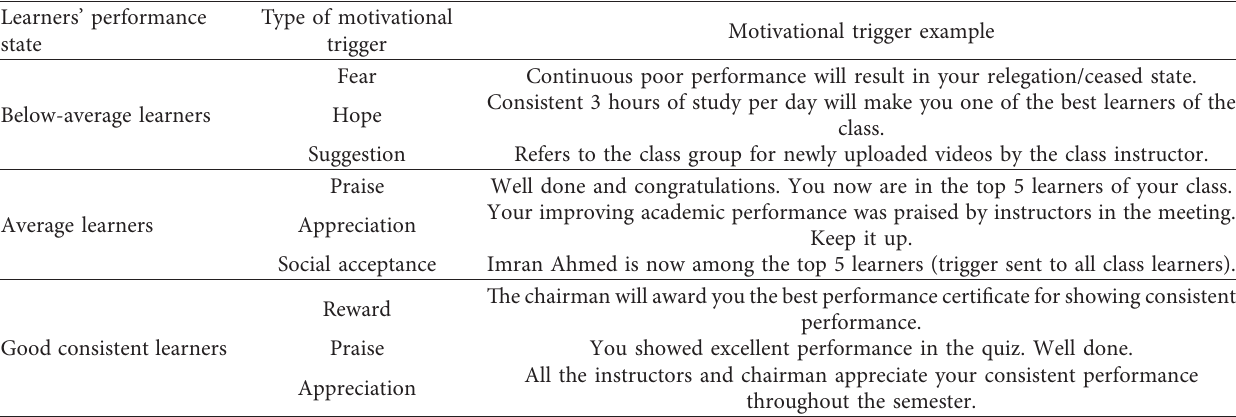
Table 6: Learners’ performance state, type of motivational triggers, and their example. Learners’